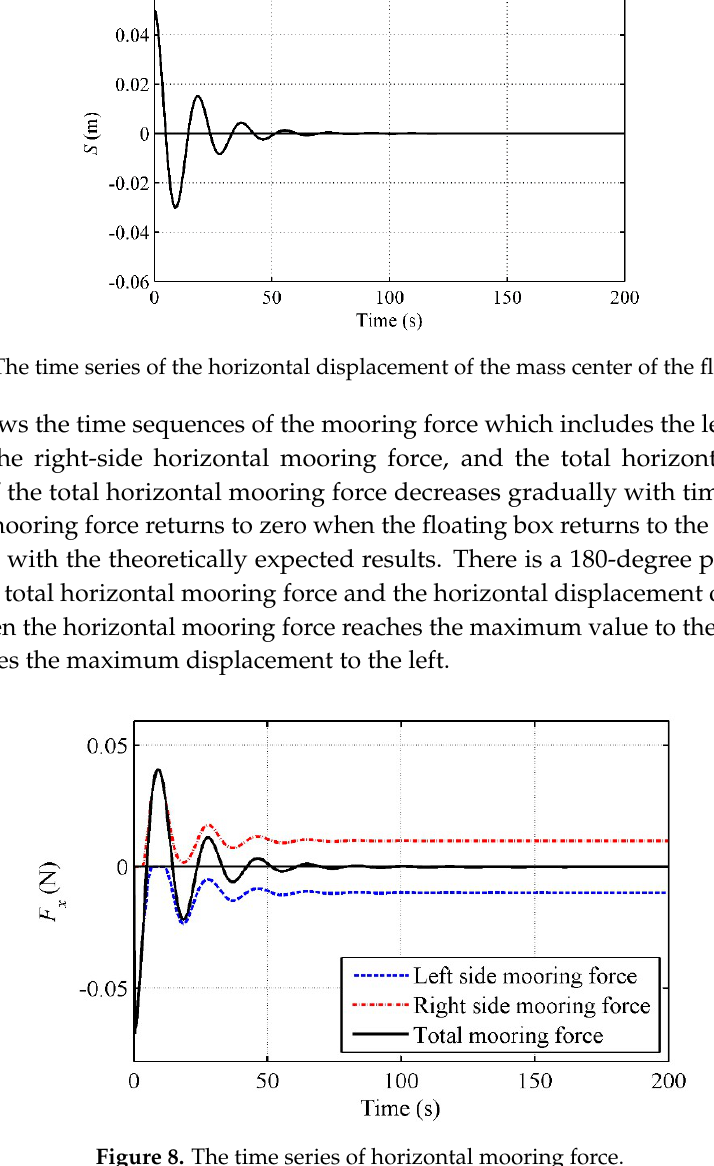
Figure 8. The time series of horizontal mooring force.